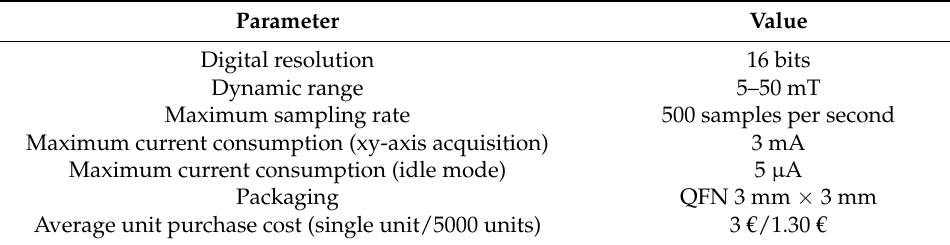
Table 1. Technical characteristics of the MLX90393